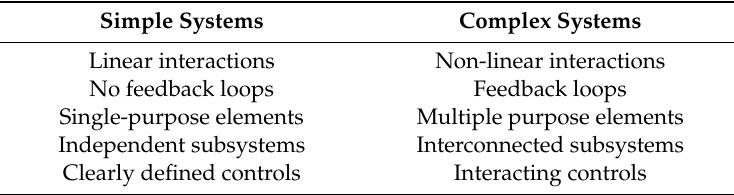
Table 1. Summary terms for linear and complex systems, adapted from Reference